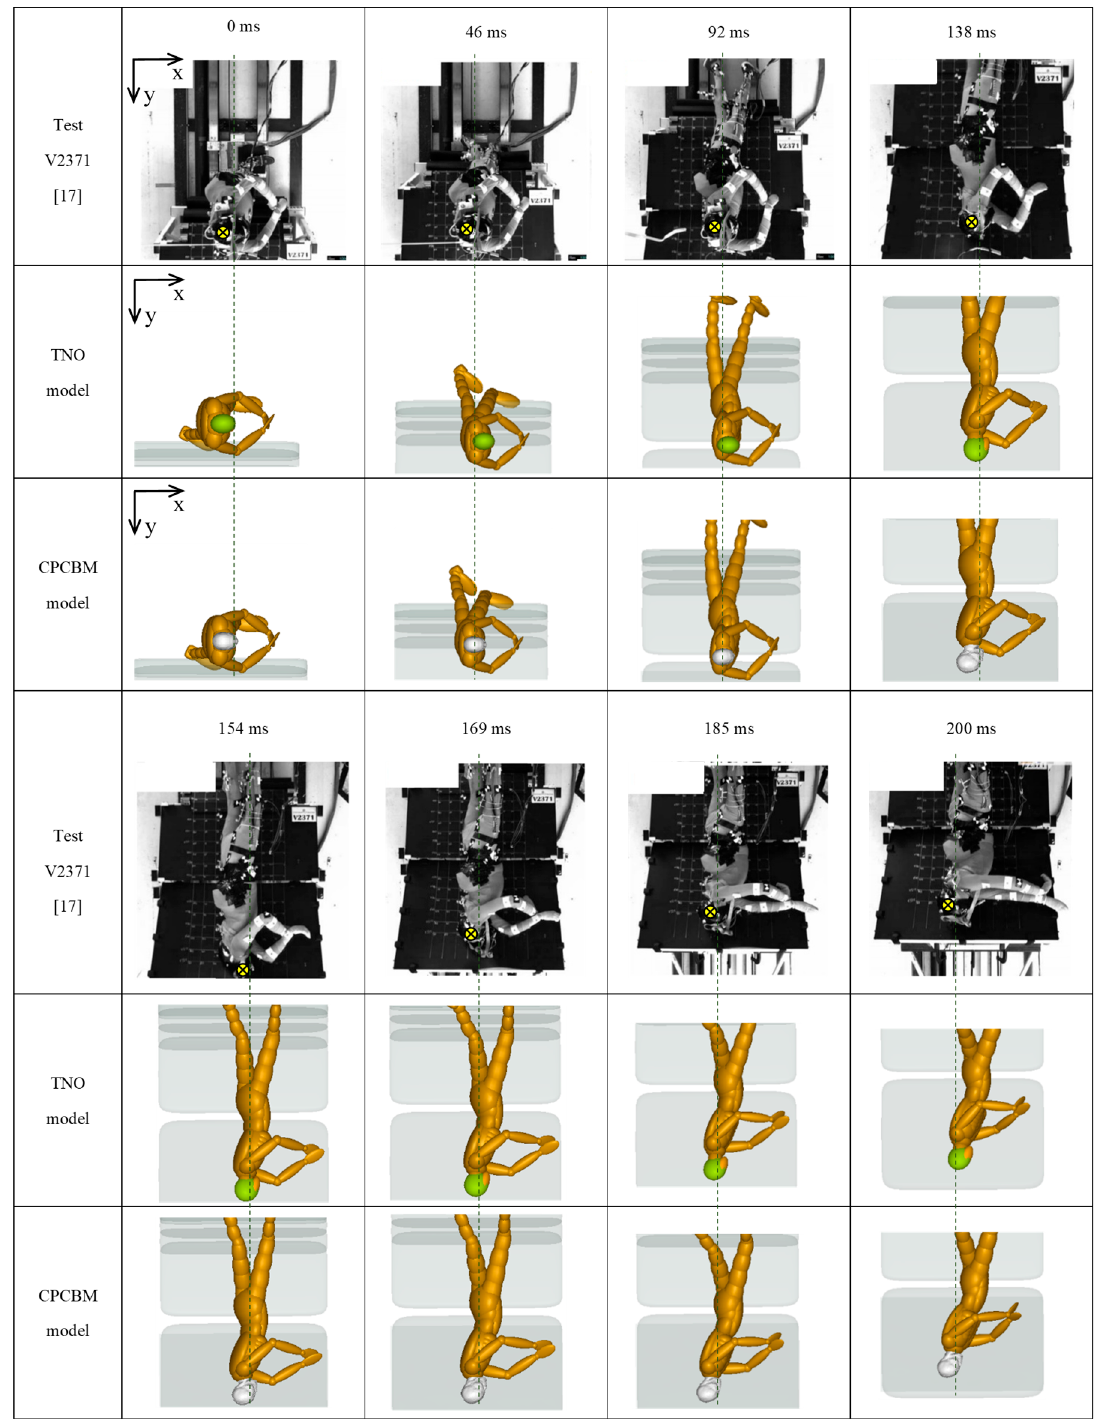
Figure A4. Motion responses of PMHS, the TNO model (gold color), and CPCBM (mixed color) for test V2371 (superior view) [17].